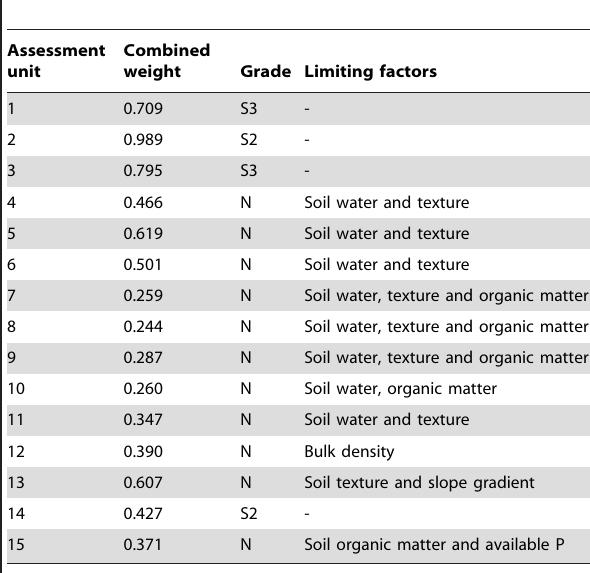
Table 6. Cropland suitability and limiting factors for each assessment unit.